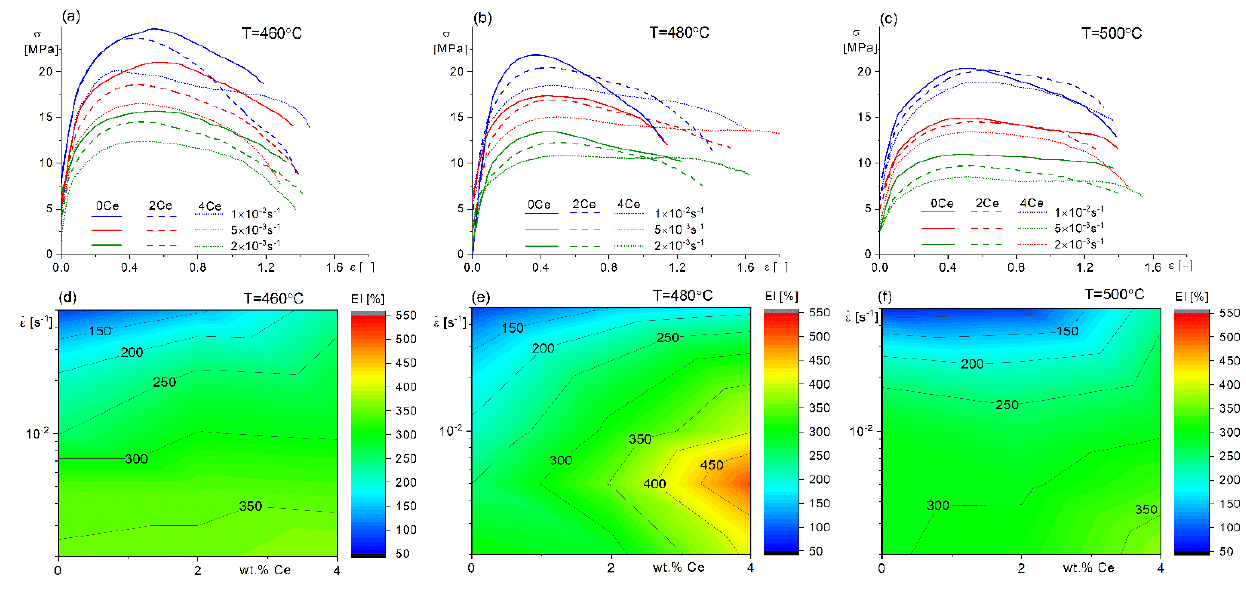
Figure 7. ( a – c ) True stress vs true strain curves for 0Ce, 2Ce, and 4Ce alloys for a constant strain rates of 2 × 10 − 3 , 5 × 10 − 3 , and 1 × 10 − 2 s − 1 ; ( d – f ) elongation-to-failure diagrams as a function of strain rate and Ce content in the alloys for the deformation temperatures of ( a , d ) 460, ( b , e ) 480, ( c , f ) 500 °C.